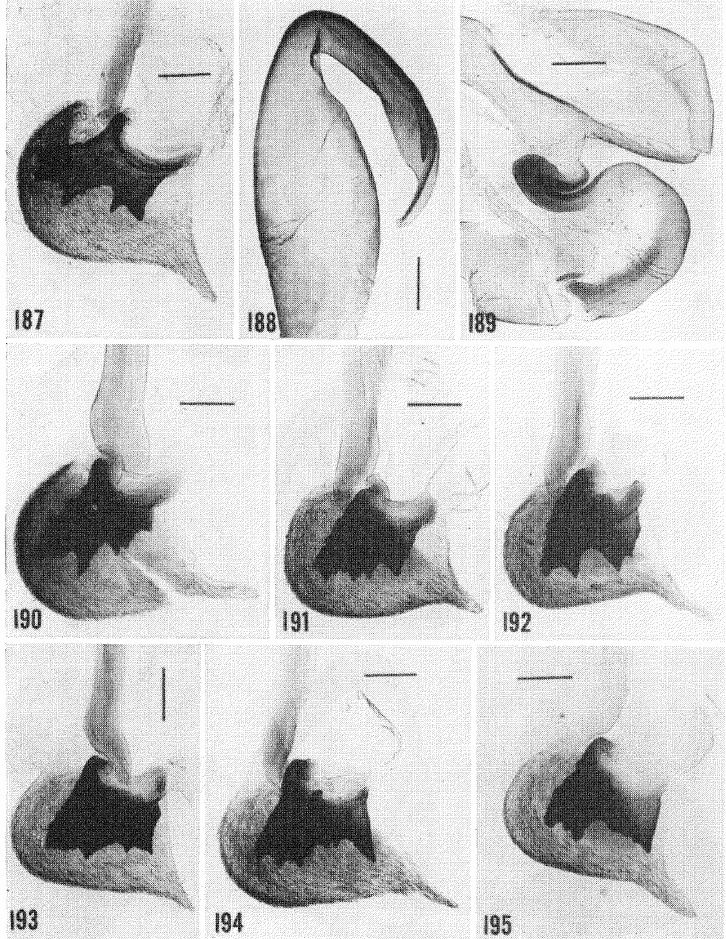
Figs. 187-195. Cockroach male genitalia. Epilampra opaca. 187-189. (70 USNM). Amapi, Brazil (det. as near berlandi by Albuquerque). 190. (88 USNM). Brownsberg, Wakti-basoe Creek, Surinam (det. as sag tta by Prin- els). 191-193. (125, 127, and 126 USNM). Napa Santa Cecilia, Rio Aguarico, Ecuador. 194-195. (89 and 87 ANSP). Provineia Sara, Dept. Santa Cruz, Bolivia, (all det. Roth). (scale 0.2